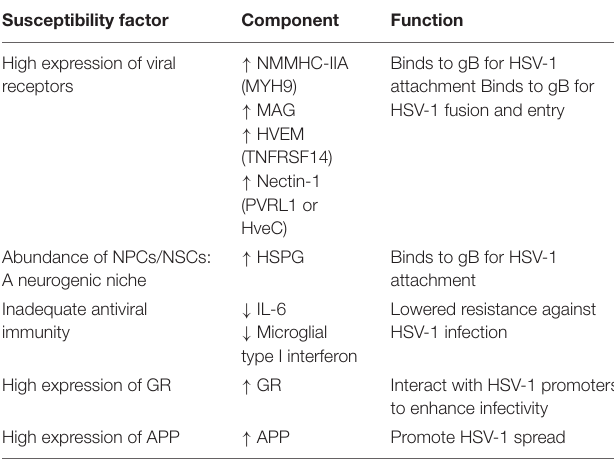
TABLE 2 | Susceptibility factors of the hippocampus toward HSV-1